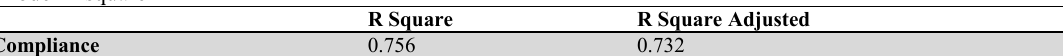
R Square R Square Adjusted